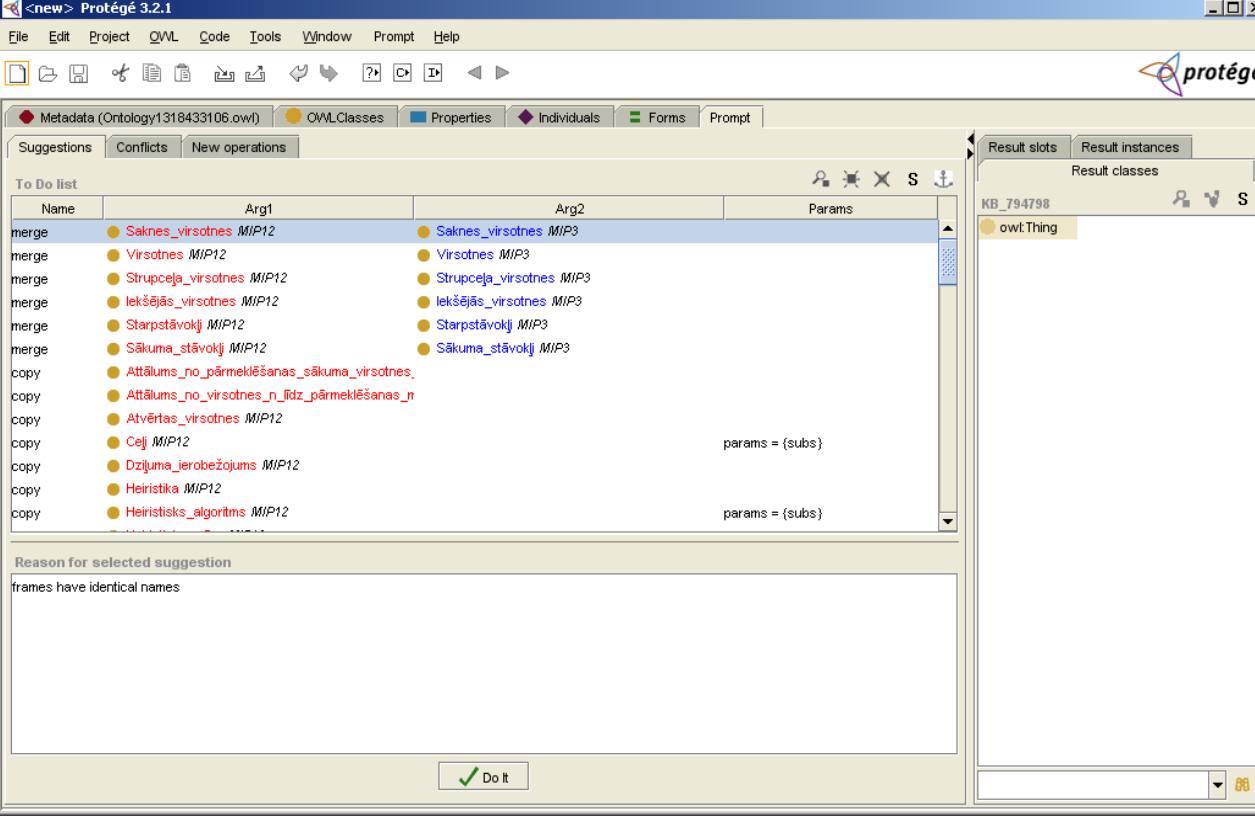
Fig. 11. Initial suggestions for ontology merge generated with